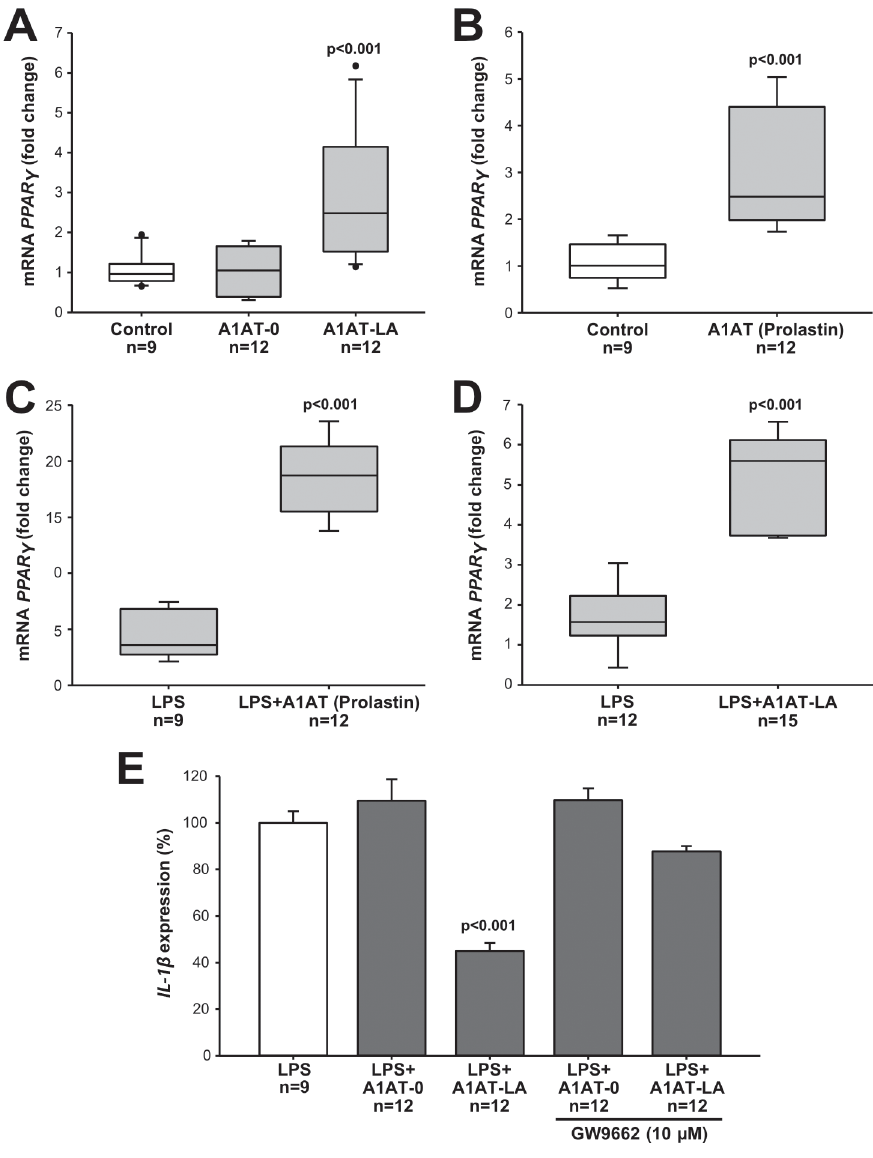
Figure 9. A1AT and LPS/A1AT induce PPAR- γ expression; effect of GW9662 on A1AT-LA ability to inhibit LPS-induced IL-1 β expression Human neutrophils (5 × 10 6 ) were incu- bated for 5 h in either medium alone, medium containing A1AT (Prolastin, 1 mg/mL) or LPS (20 ng/mL) in the absence or presence of A1AT-0 (1 mg/mL) or A1AT-LA (1 mg/mL). Expression of PPAR- g (A–D) was analyzed by real-time qPCR as described in Materials and Methods. GAPDH and HPRT were used as housekeeping genes. Box plots repre- sent data from 3 individual donors; n = number of replicates for each experiment. P value indicates significant differences compared with the values seen in control cells (A and B) or LPS (C and D). (E) Cells were pretreated for 30 min with 10 μ M GW9662, an irreversible PPAR- γ antagonist, prior to addition of LPS or LPS/A1ATs. Data are expressed as percentage of IL-1 b gene expression in cells activated with LPS (100%) and show means (SD) of 3 independent donors; n = number of replicates for each experiment. P < 0.001 represents significant difference compared with the values seen in LPS-activated